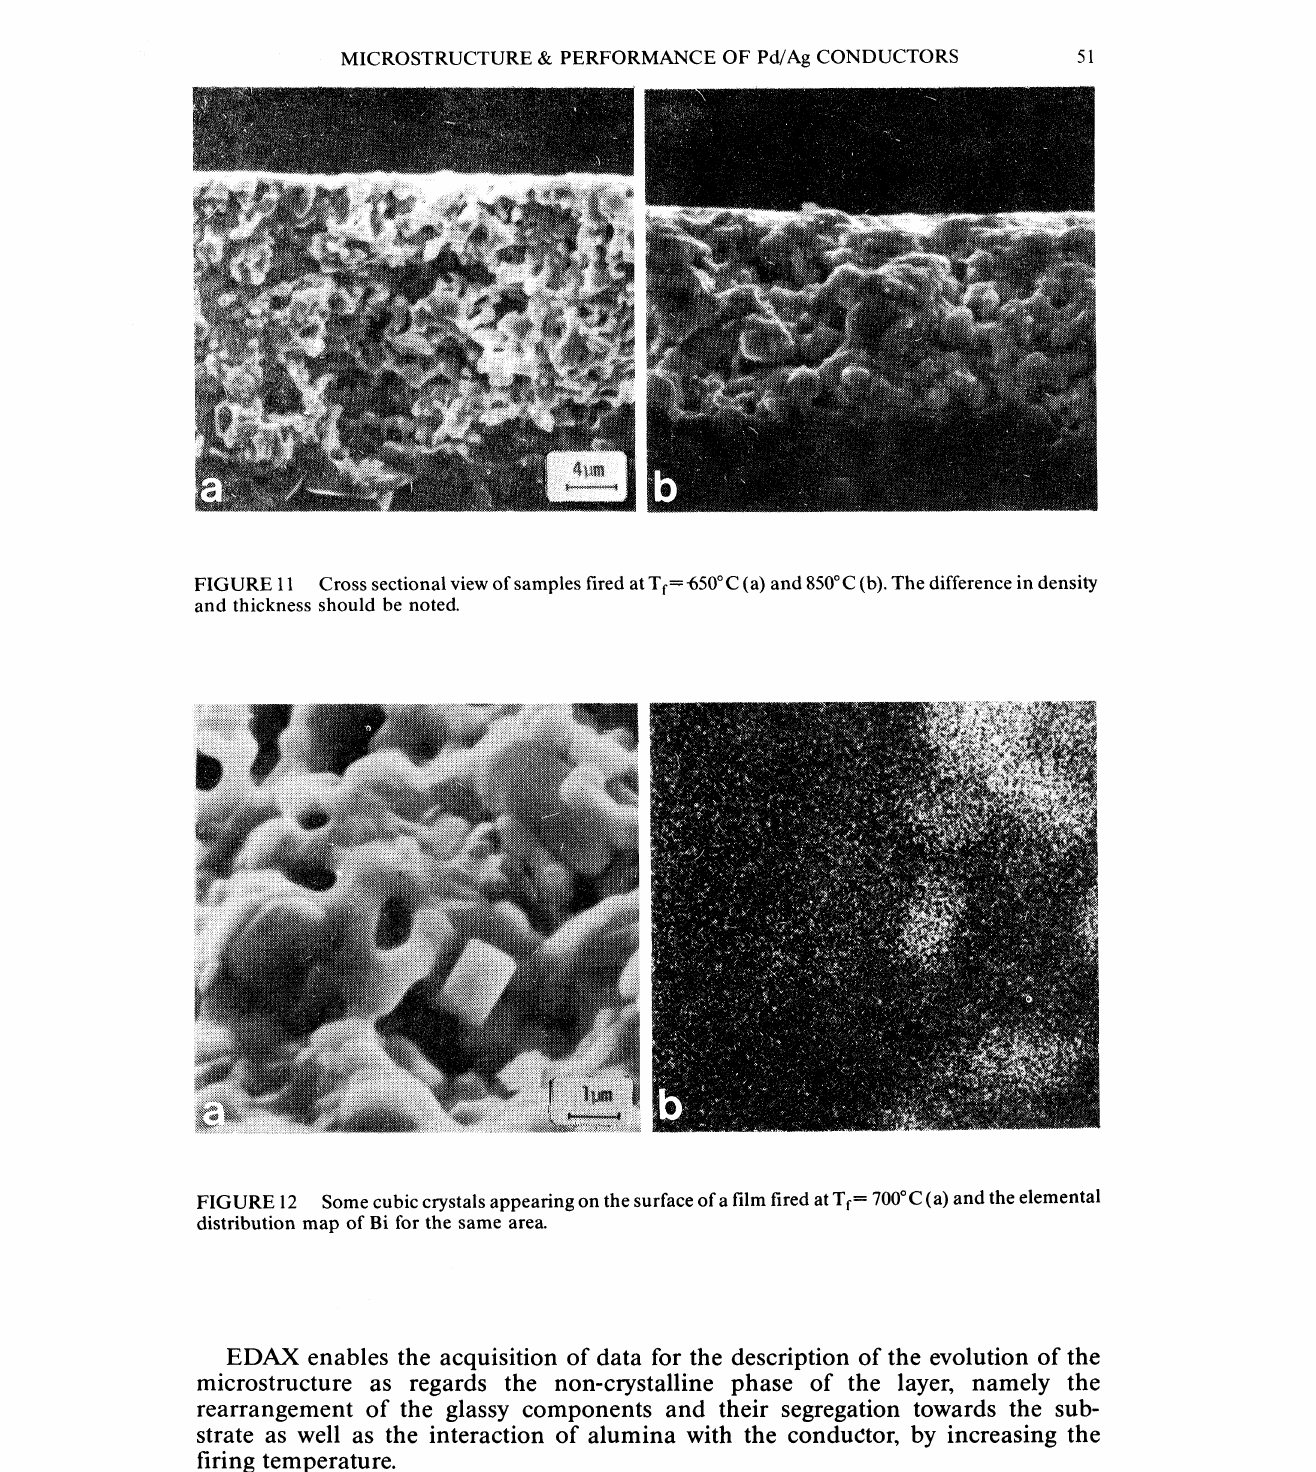
FIGURE 12 Some cubic crystals appearing on the surface of a film fired at Tf-- 700C (a) and the elemental distribution map of Bi for the same area.